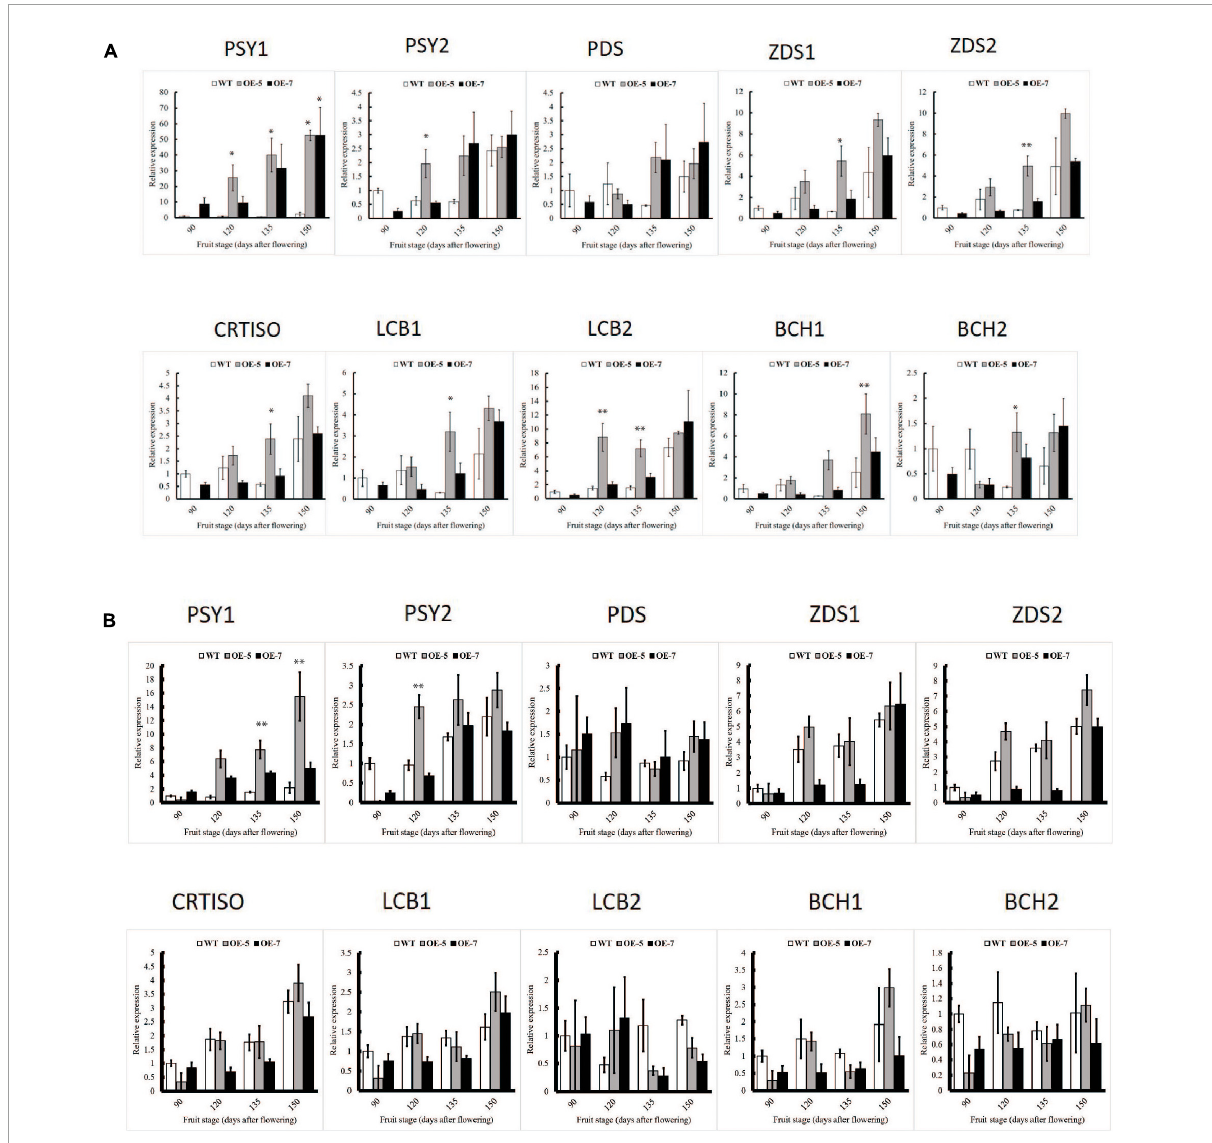
FIGURE3 Comparison of carotenoid gene expression in wild-type (WT) and PSY ‘Royal Gala’ apple lines, OE-5 and OE-7, as determined by qPCR, relative to expression of housekeeping genes ( MdActin and MdEF1A ) in fruit skin (A) and fruit flesh (B) . Bars represent means and SE of four biological replicates. PSY, phytoene synthase; PDS, phytoene desaturase; ZDS, zeta carotene desaturase; CRTISO, carotene isomerase; LCB, lycopene beta-cyclase; BCH, beta-carotene hydroxylase. Bar graph with asterisk shows significant difference from WT at the same fruit stage using Dunnett’s test (* P < 0.05; ** P <